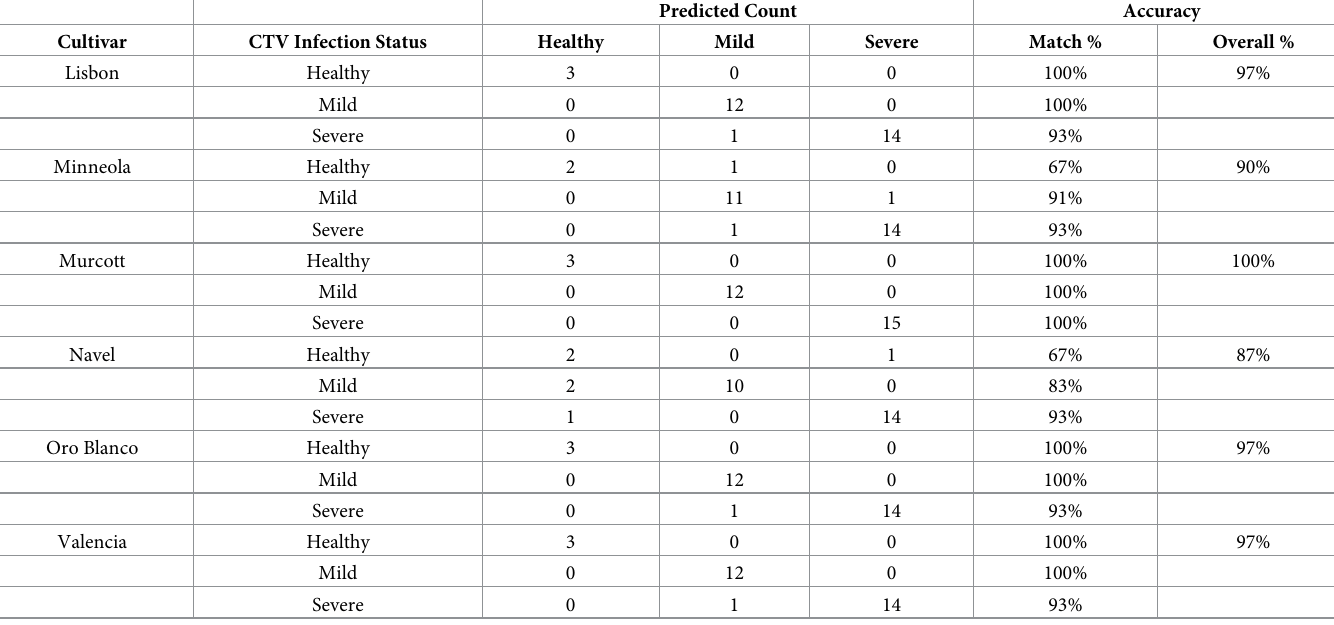
Table 4. CDA utilizing